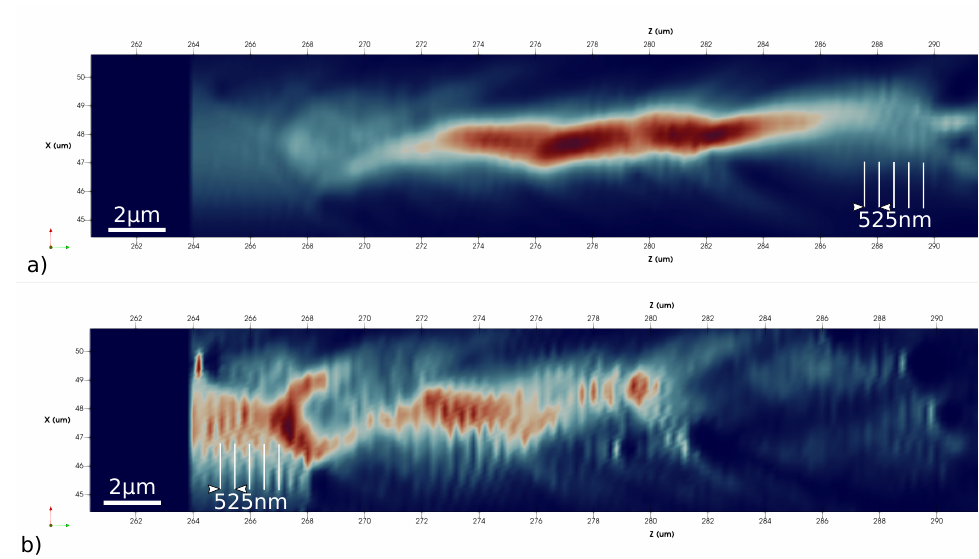
Figure 9. Pattern observed in the history of the photo-ionized electron history for ( a ) voids and ( b ) metal